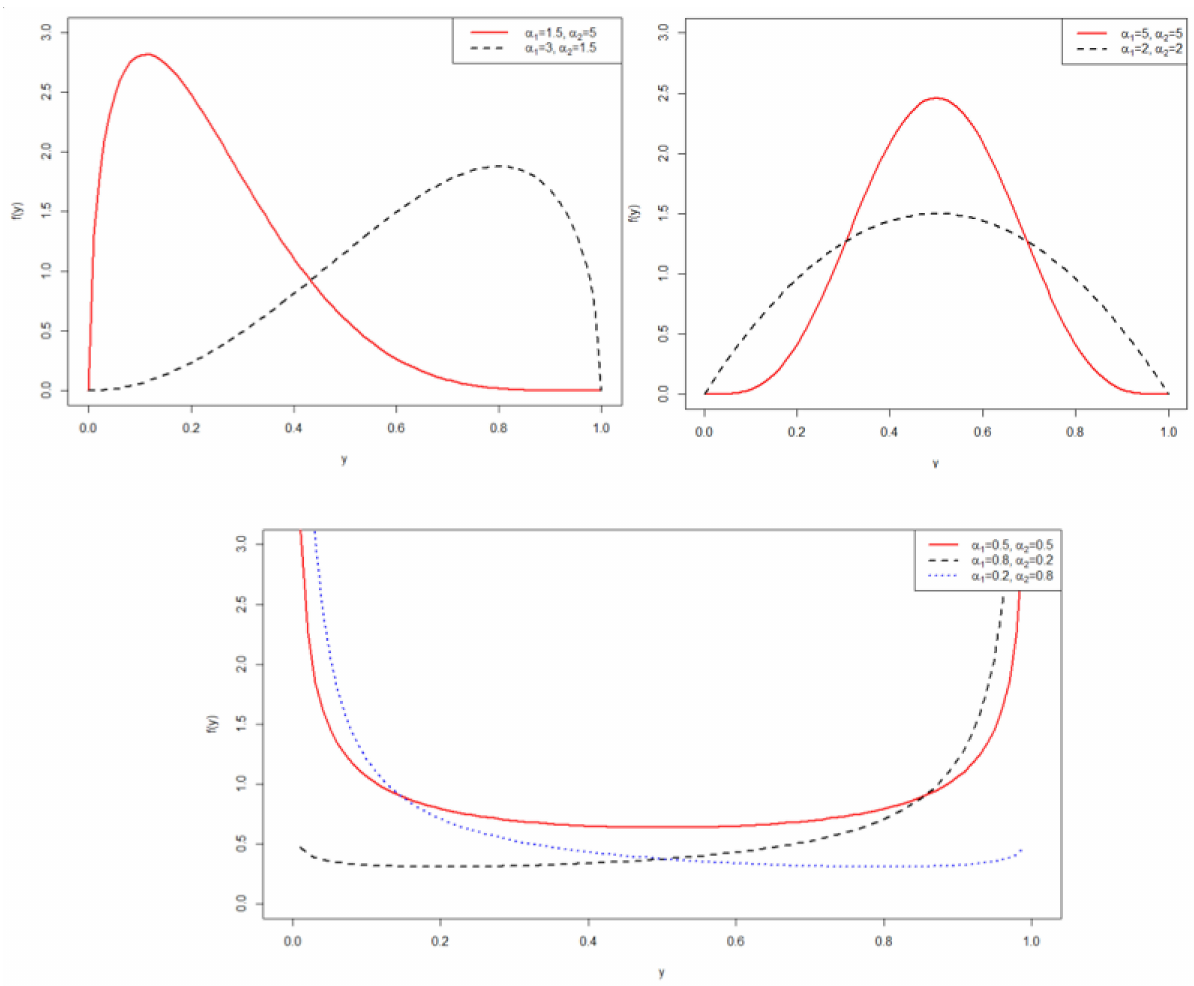
Figure 1. Different distribution shapes according to the different values of the parameters of the Beta